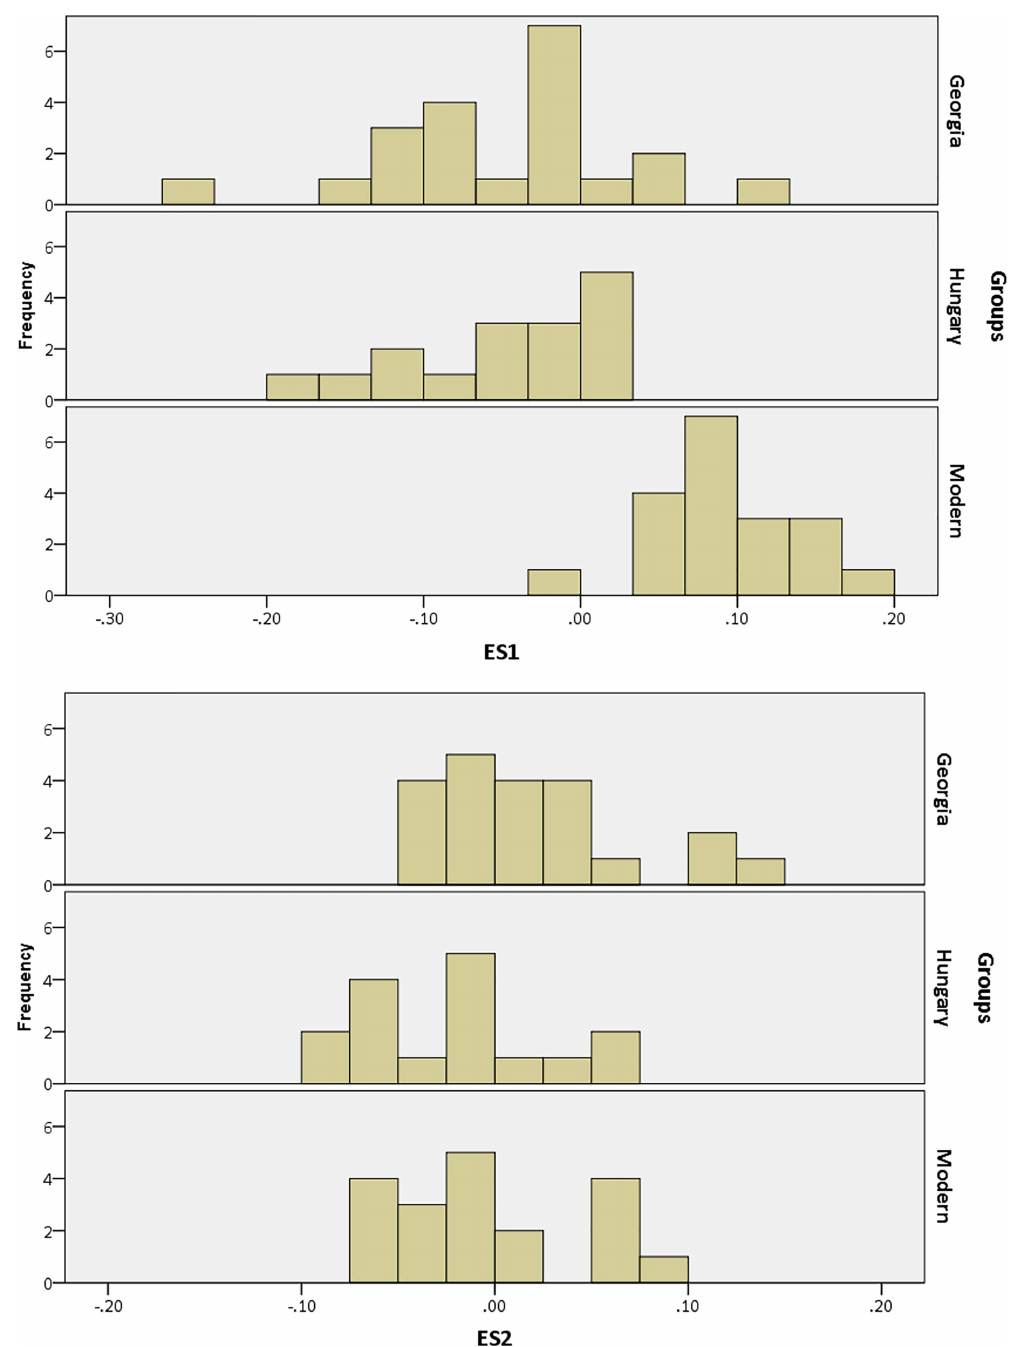
Fig 8. Histograms depicting the eigenscores of Georgian, Hungarian and modern crania on ES1 and